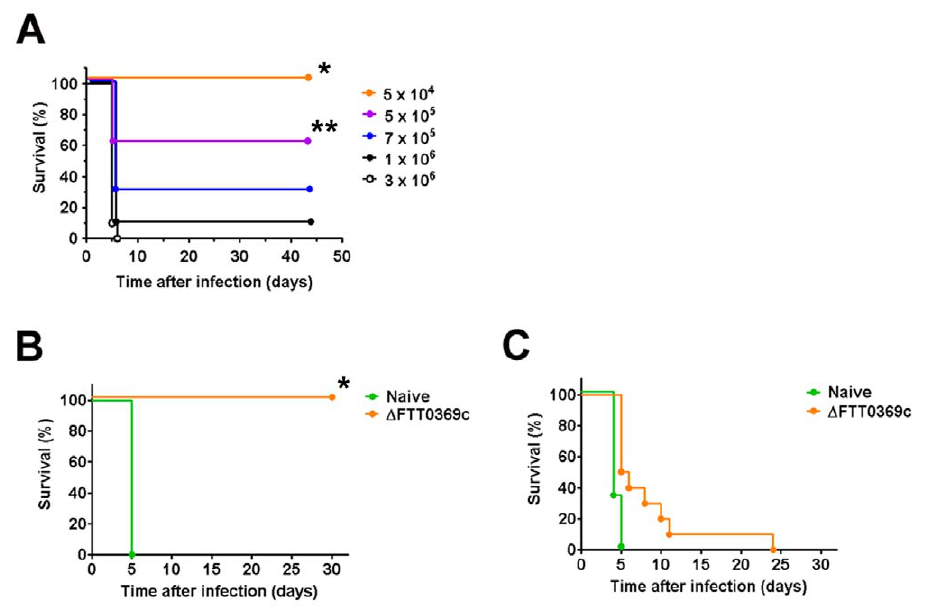
Figure 4. LD50 of SchuS4 D FTT0369c and protective efficacy following increased challenge dose of wild type SchuS4. (A) Balb/c mice (n=10/group) were infected intradermally with the indicated number of F. tularensis D FTT0369c. Mice were regularly monitored for up to 45 days after infection and euthanized at the first signs of irreversible illness. (B and C) Mice (n=10/group) were challenged with approximately 5 6 10 4 CFU intradermally. Forty-five days after infection mice were challenged intranasally with approximately 50 CFU (B) or 200 CFU (C) wild type SchuS4. Mice were regularly monitored for up to 30 days after infection and euthanized at the first signs of irreversible illness. *=p , 0.05 compared to all other groups. **=p , 0.05 compared to mice receiving 7 6 10 5 , 1 6 10 6 and 3 6 10 6 .